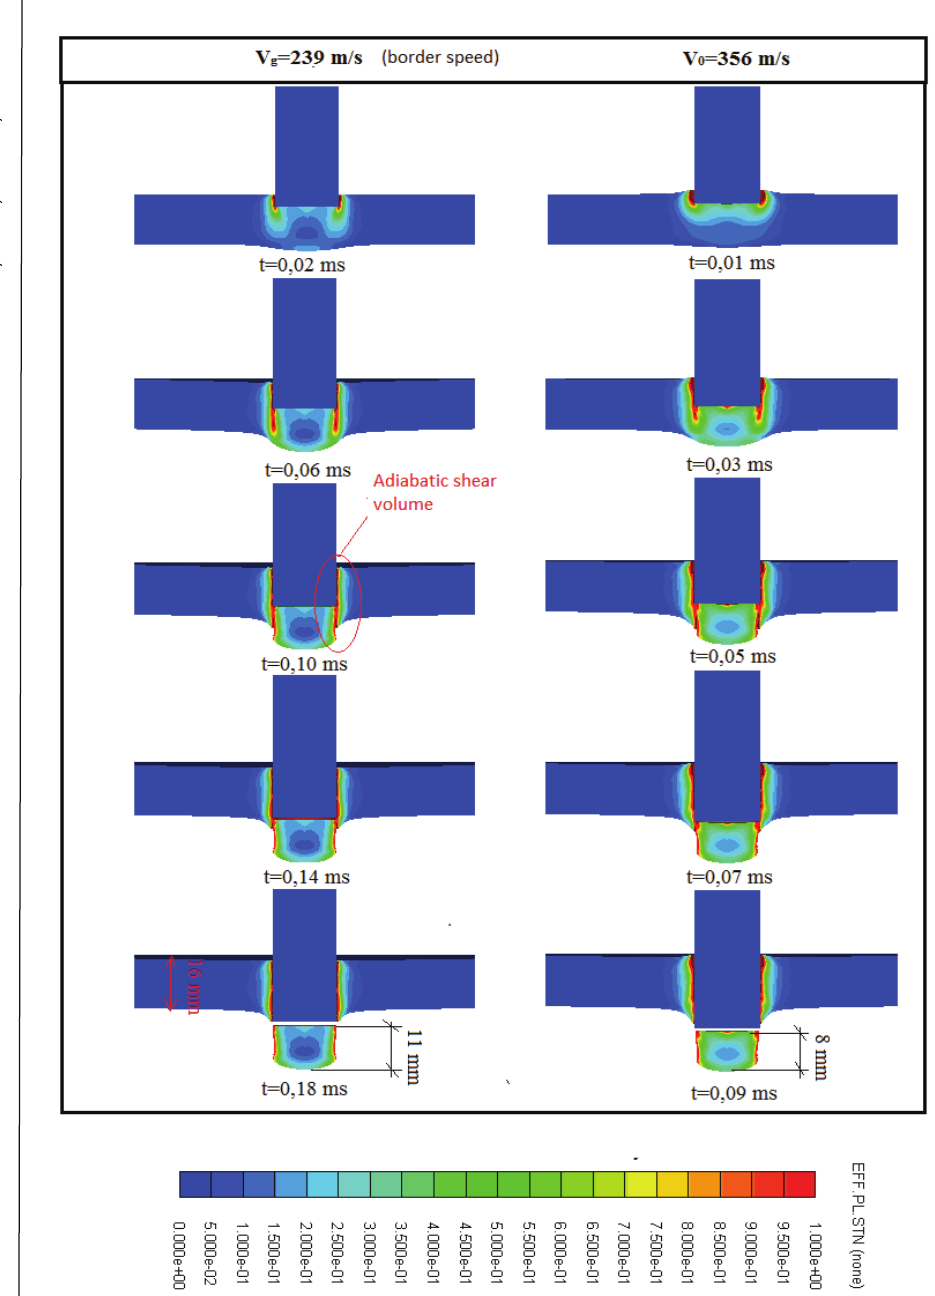
Figure 36 – Comparison of blunt projectile penetration through a 16mm-thick steel plate at two speeds, Vo=239 m/s and Vo=356 m/s, FEM